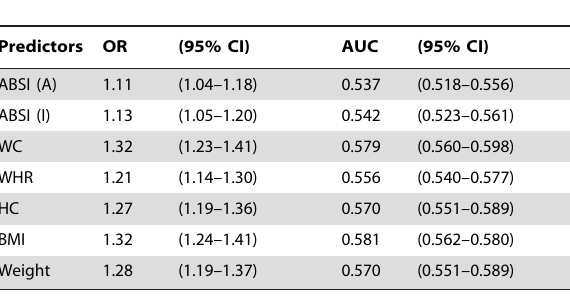
Table 5. Odds ratios (OR) estimated from logistic regression analysis and area under curve (AUC) estimated from receiver operating characteristic analysis of incident hypertension in relation to anthropometric indices in age-and-gender standardized z-scores (n=3788).